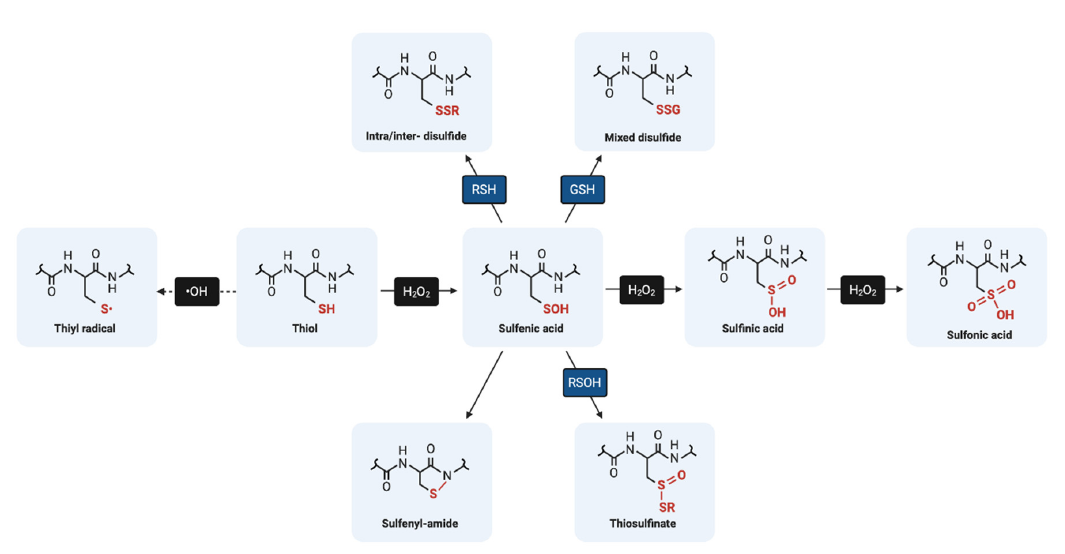
Figure 1. Biologically relevant oxidative post-translational modifications of cysteine.